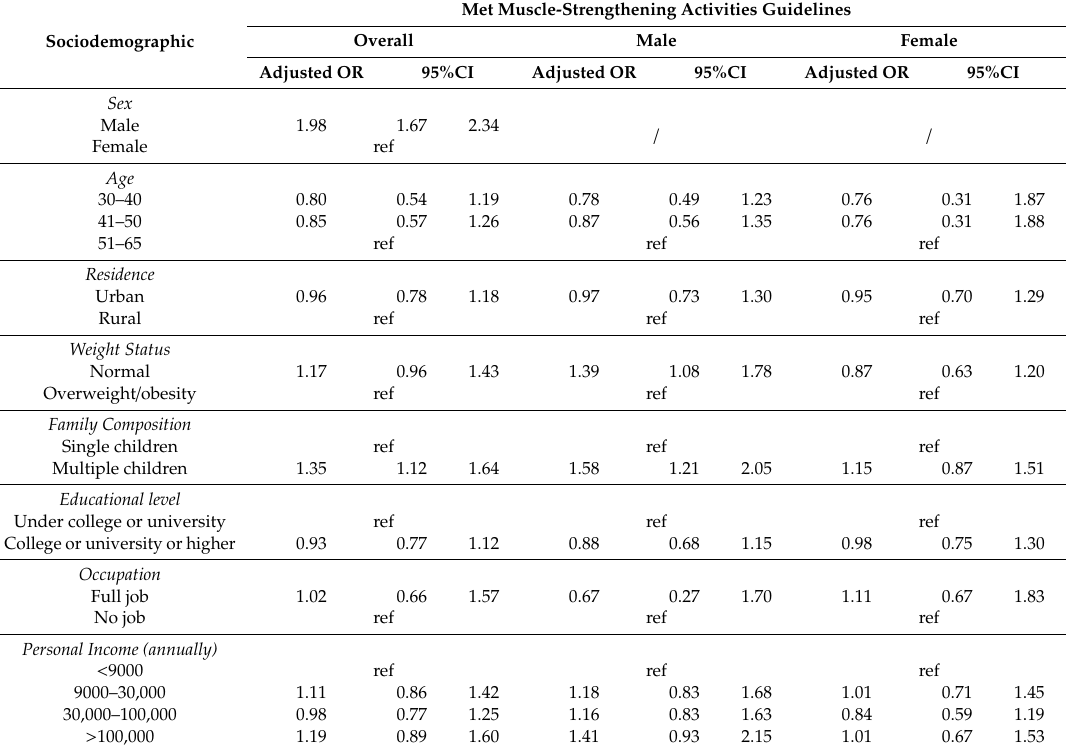
Table 3. Associations of sociodemographic correlates with meeting the MS activities